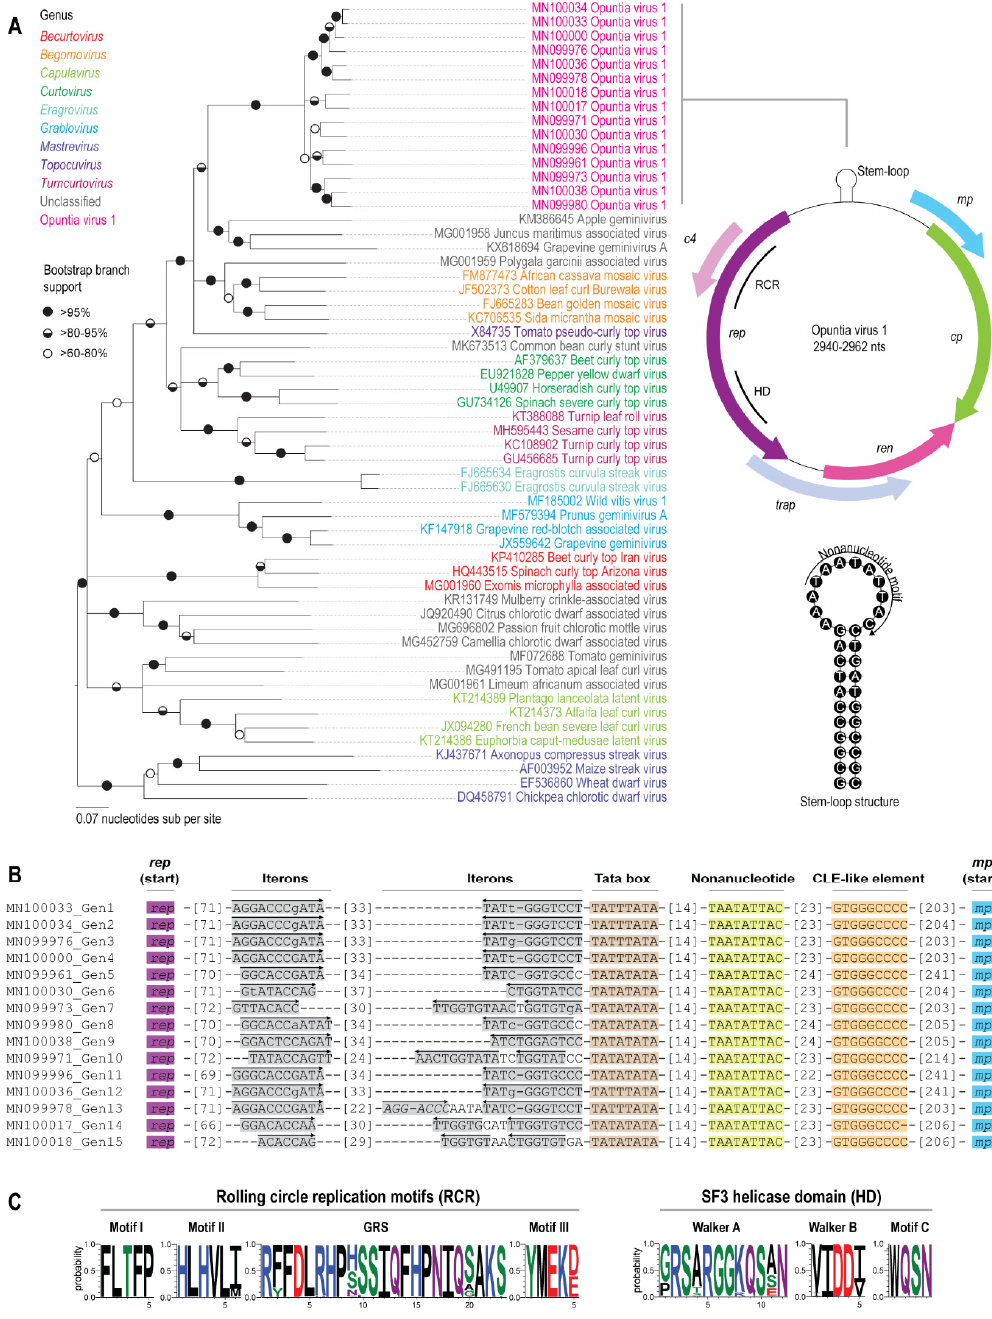
Figure 1. ( A ). Neighbor-Joining phylogenetic tree of the full-length genome of representatives of the 15 genotypes of OpV1 with those of the family Geminiviridae . Branches with < 60% bootstrap support are collapsed, and the tree is midpoint-rooted. The genomic organization of OpV1 and the stem–loop structure containing the nonanucleotide motif are shown to the right of the phylogenetic tree. ( B ). Nucleotide sequence and organization of origin of replication-associated iterative sequences “iterons” in the intergenic region. Arrows indicate the orientation of the iterons with respect to the nonanucleotide sequence. Lower-case letters in an iterated element indicate a nucleotide that does not match in all the iterons from OpV1 viruses of that same genotype. The TATA box, nonanucleotide motif and conserved late element (CLE)-like sequence. ( C ). Graphic representation of the variation in amino acids in the motifs from the SF3 helicase domains and the rolling circle replication motifs present in the Rep sequences of the 79